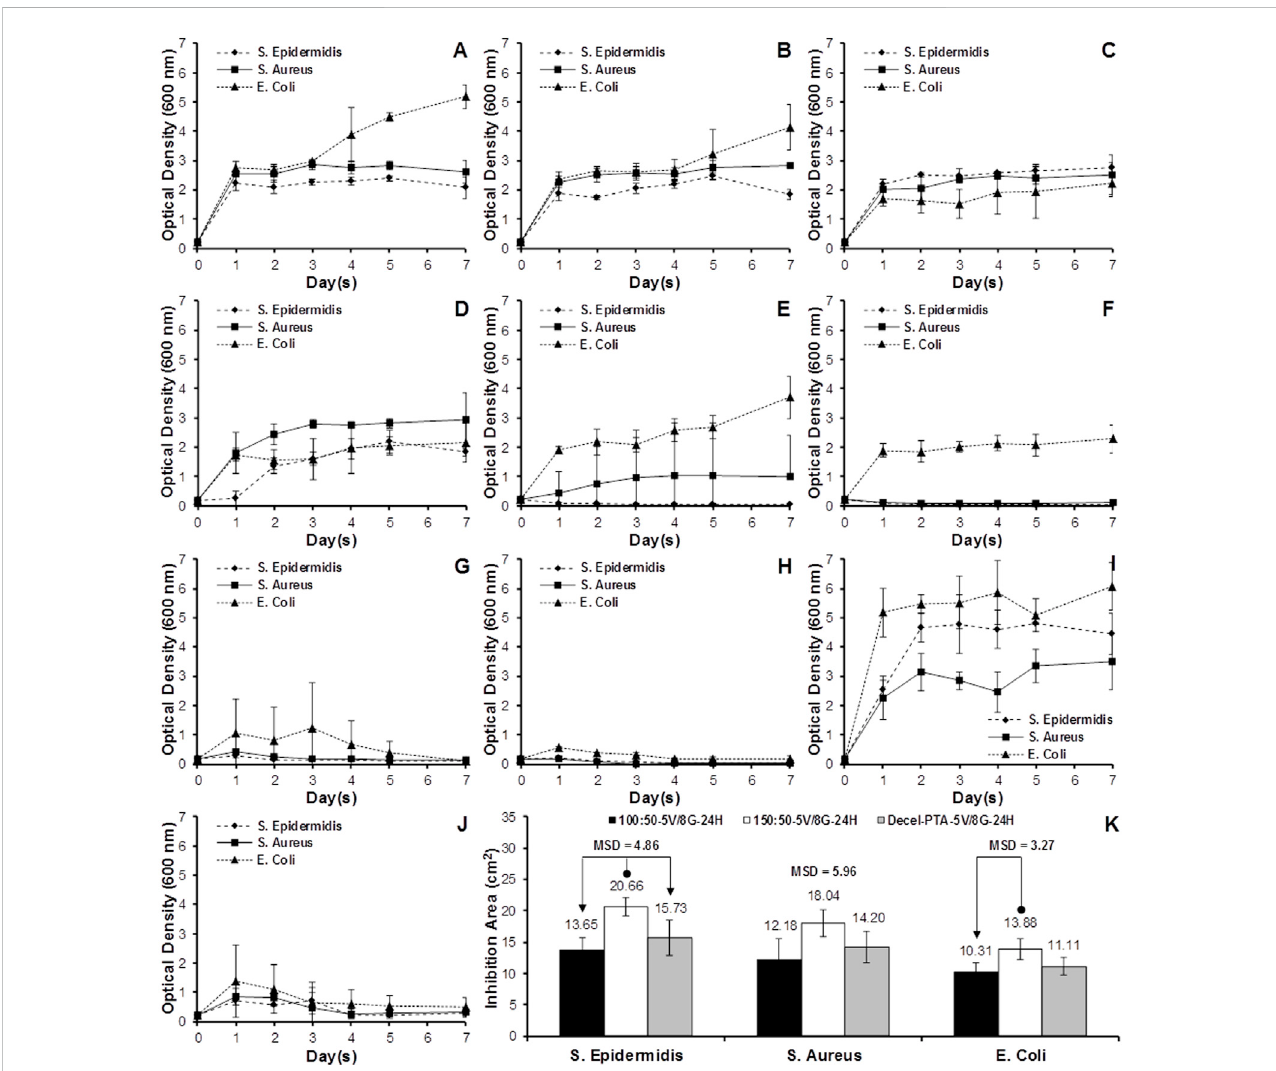
FIGURE 8 Bacteriagrowthcurvesforthepolymerblends (A – I) anddecellularizedPTA (J) ,inoculatedwith S.Aureus , S.Epidermidis or E.Coli . (A) 100:50A(5 mg/mL VANand5 mg/mLGENsupplementedinelectrospinningsolution); (B) 150:50A(5 mg/mLVANand5 mg/mLGENsupplementedinelectrospinningsolution); (C) 100:50-5V/5G-1H (100:50 soaked in 5 mg/mL VAN and 5 mg/mL GEN for 1 h); (D) 150:50-5V/5G-1H (150:50 soaked in 5 mg/mL VAN and 5 mg/mL GEN for 1 h); (E) 100:50-5V/5G-24H (100:50 soaked in 5 mg/mL VAN and 5 mg/mL GEN for 24 h); (F) 150:50-5V/5G-24H (150:50 soaked in 5 mg/mL VAN and 5 mg/mL GEN for 24 h); (G) 100:50-5V/8G-24H (100:50 soaked in 5 mg/mL VAN and 8 mg/mL GEN for 24 h); (H) 150:50-5V/8G-24H (150:50 soaked in 5 mg/mL VAN and 8 mg/mL GEN for 24 h); (I) 15:50-W/O (150:50 without antibiotics); (J) Decel-PTA-5V/8G-24H (M2-PAA decellularized PTA soaked in 5 mg/mL VAN and 8 mg/mL GEN for 24 h). (K) Mean bacteria inhibition area for the 100:50-5V/8G-24H, 150:50-5V/8G-24H and